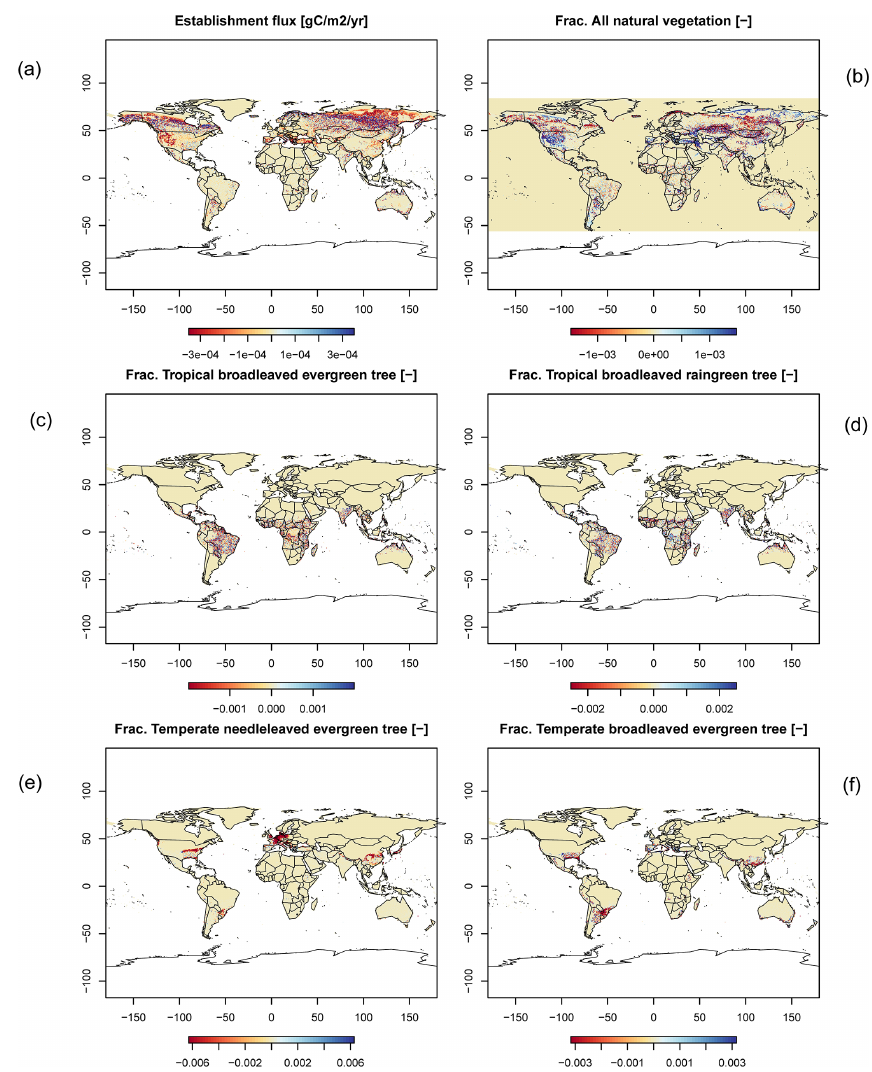
Figure C4. Difference maps of (a) establishment, (b) all natural vegetation, (c) frac. tropical broadleaved evergreen, (d) frac. tropical broadleaved raingreen, (e) frac. temperate needle-leaved evergreen, and (f) frac. temperate broadleaved evergreen.